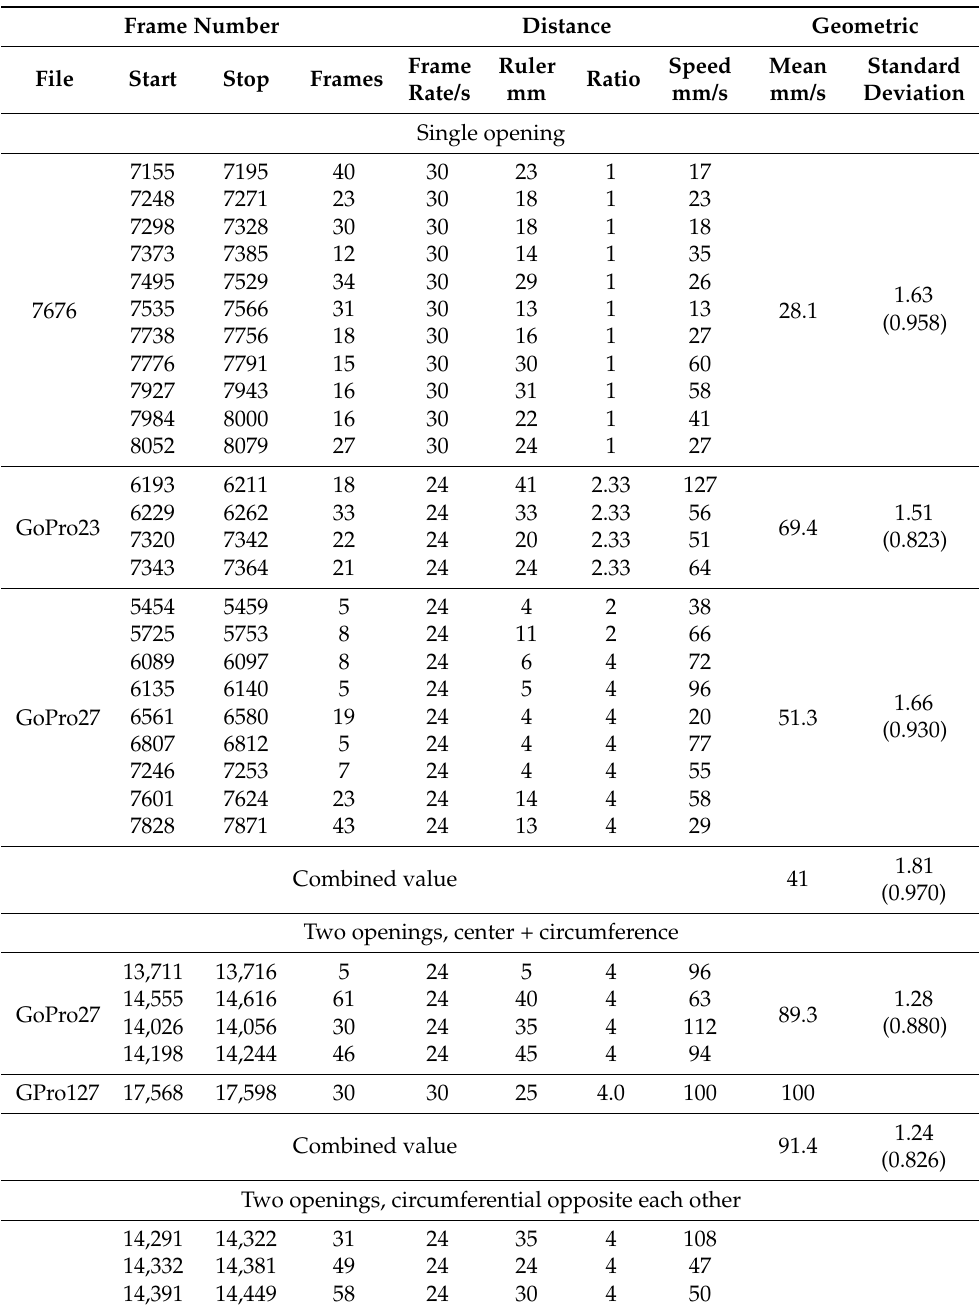
Table 3. Air motion downward in the opening, underside of manhole